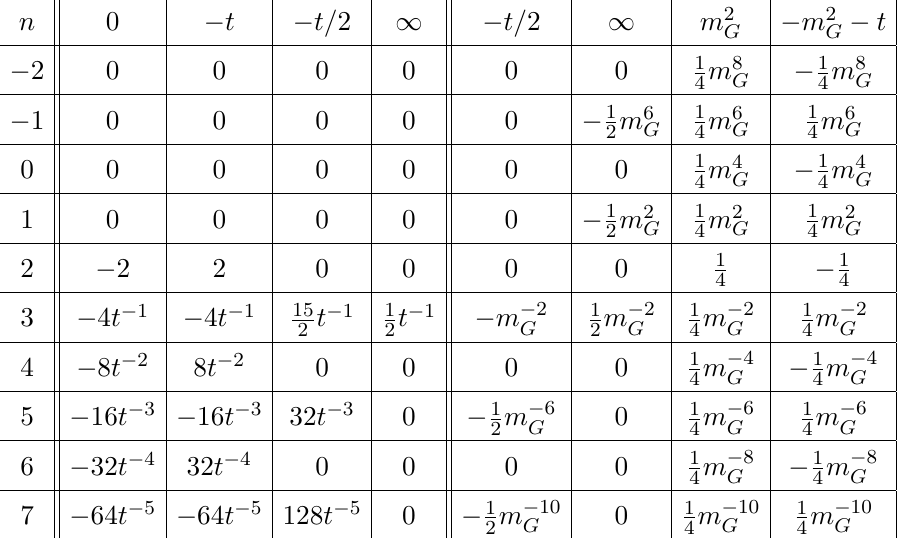
Table 1 . Residues of poles of A ( s ) in (3.5). The pole locations are given at the top. The poles ( n,t ) at − t/ 2 and ∞ each have two columns since there are two types of contributions to their residues. The left half of the table is due GR and the right half is due to the UV